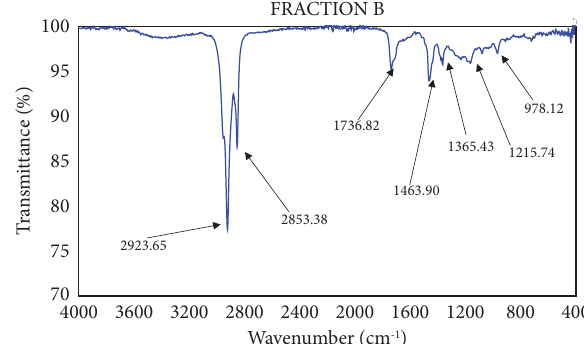
Figure 9: FTIR spectrum of petroleum ether crude extract of C. nioroense.